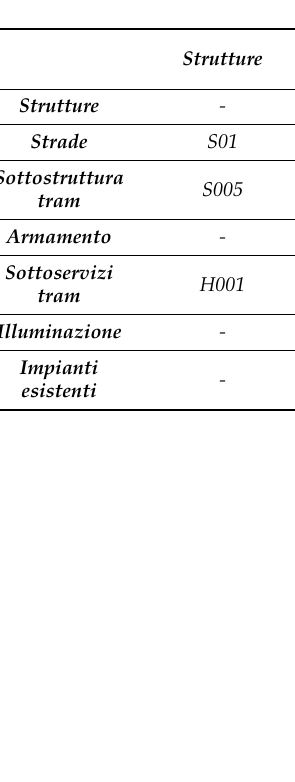
Table 1. Coordination matrix for Clash Detection activity.